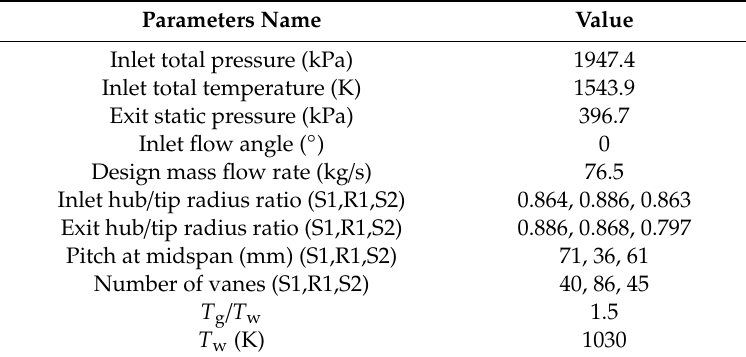
Table 1. Design parameters and boundary conditions of the 1.5-stage